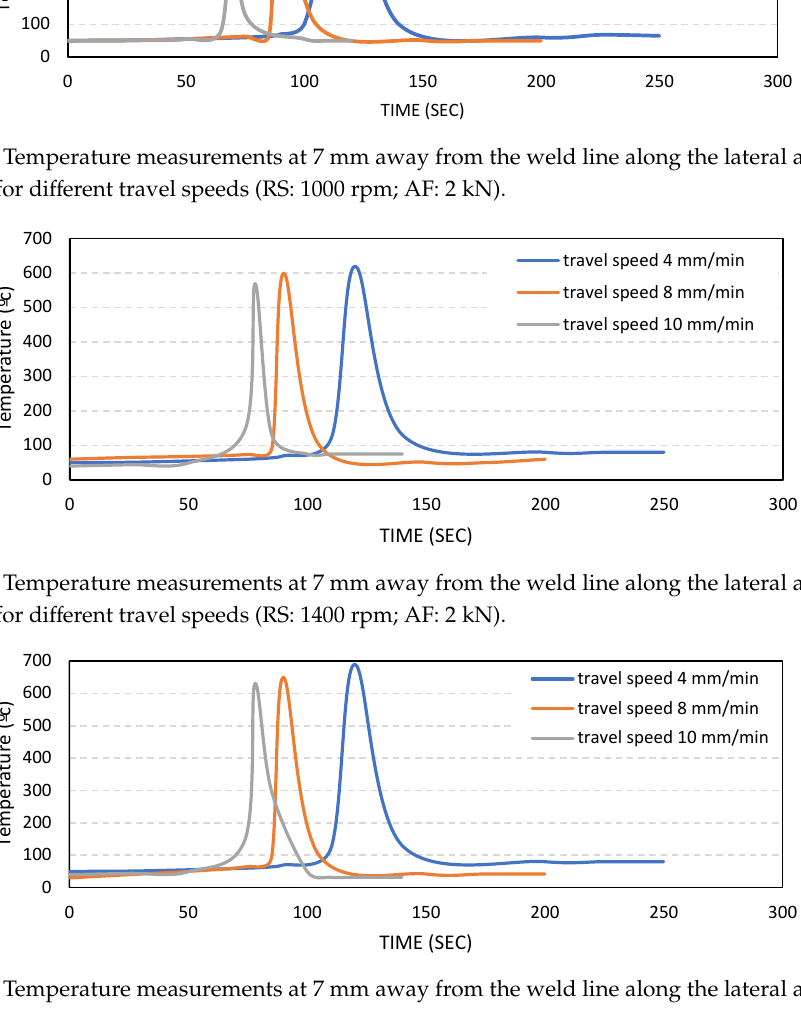
Figure 15. Temperature measurements at 7 mm away from the weld line along the lateral axis of the specimen for different travel speeds (RS: 1800 rpm; AF: 2 kN).